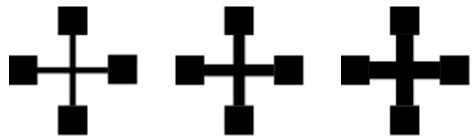
Figure 2. Test structures for the measurement of the sheet resistance with three di ff erent line length to width ratios.